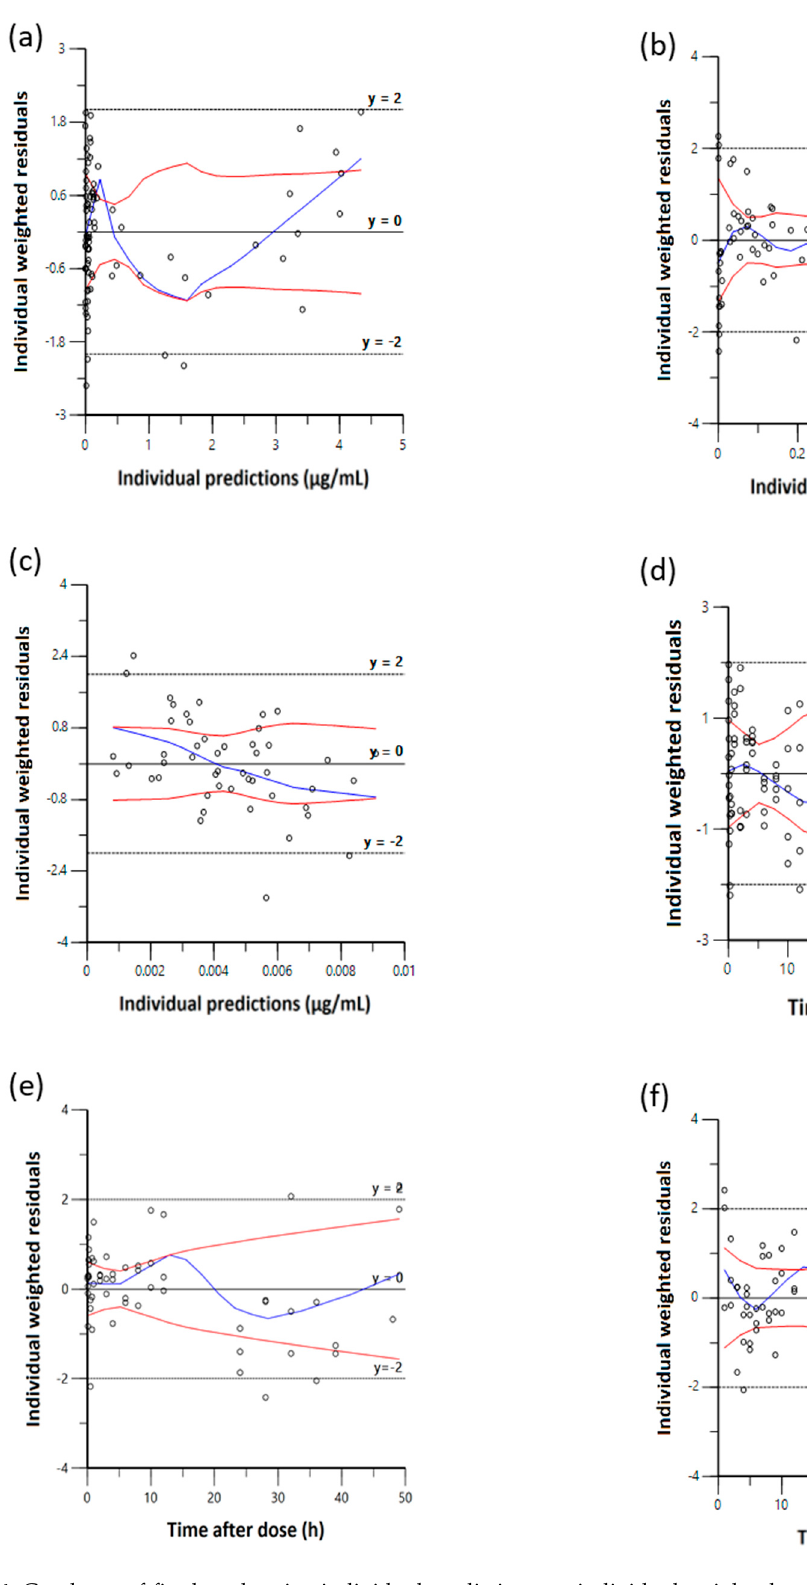
Figure 4. Goodness-of-fit plots showing individual predictions vs. individual weighted residuals of MPA: ( a ) IV; ( b ) oral; ( c ) supralingual. Individual weighted residuals vs. time after dose: ( d ) IV; ( e ) oral; ( f ) supralingual.